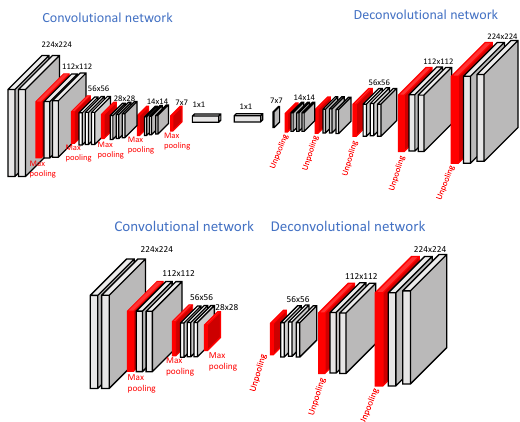
Figure 1. Top : Original DeconvNet architecture, Bottom : Proposed light-weight network